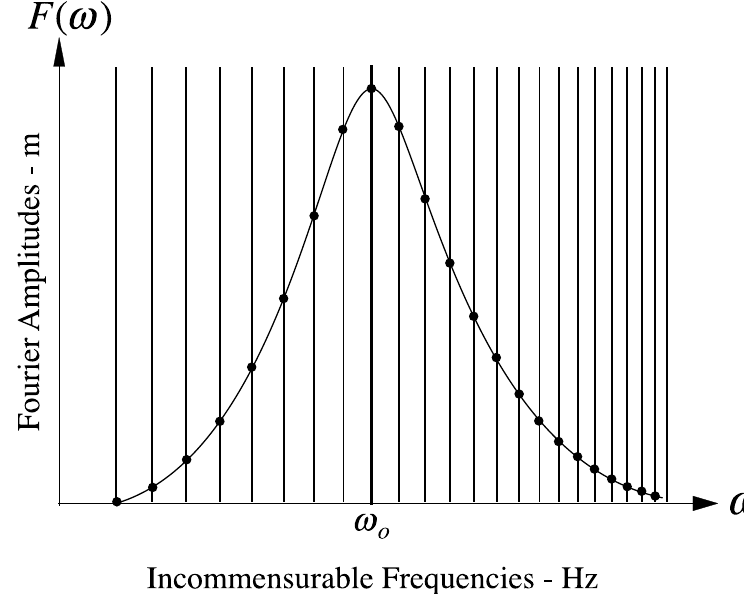
Figure 23. A Fourier spectrum of the 1+1 LSE equation with incommensurable frequencies given by the dispersion relation (183).